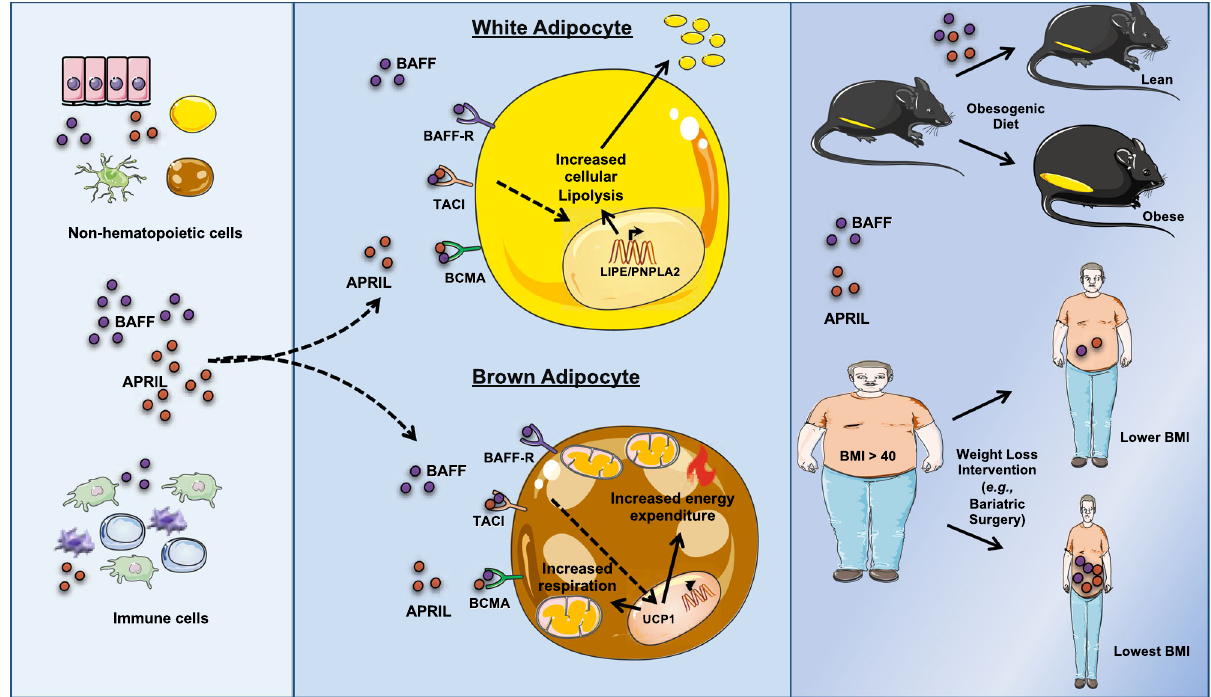
Fig. 8 BAFF and APRIL axis regulates adipose tissue/adipocyte function and body weight gain. A proposed model of the impact of the BAFF/APRIL axis on white and brown AT/adipocyte lipid handling. BAFF/APRIL regulation of AT/adipocytes function is associated with protection from DIO in mice. The effect of this axis positively correlates with greater loss of body weight in bariatric